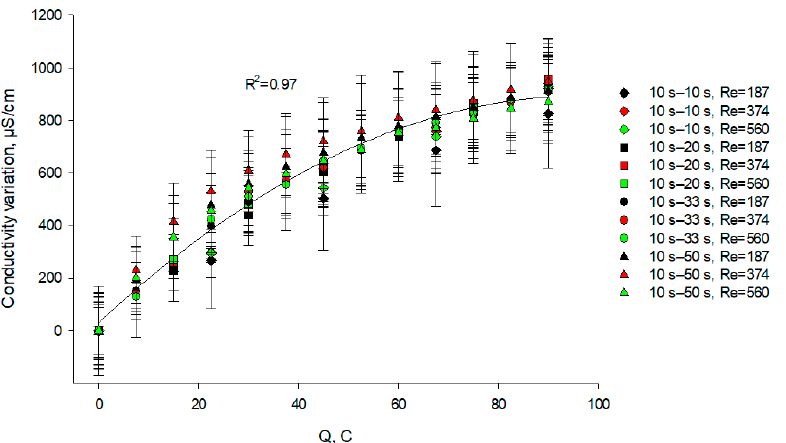
Figure 8. Evolution of KCl stream conductivity variation as a function of the amount of transferred charges (in C) during EDBM in PEF mode carried out at different flow rates (expressed in Reynolds numbers) and different pause durations; the regimes studied: 10 s–10 s, 10 s–20 s, 10 s–33 s and 10 s–50 s. Reynolds numbers of 187, 374 and 560 correspond to linear velocities of 7.8, 15.6 and 23.4 cm/s, respectively.